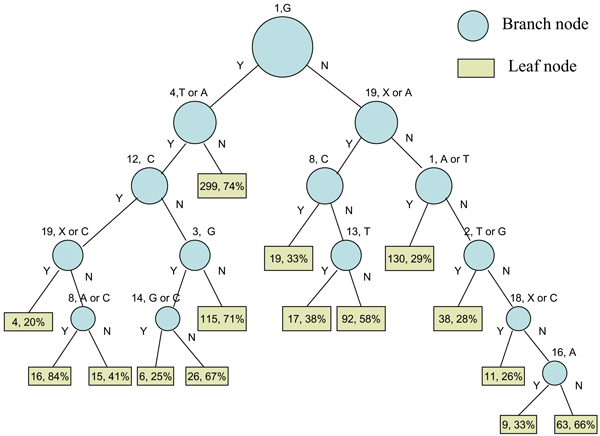
Decision tree diagram for known 860 effective and 860 ineffective siRNA sequences. The top of the branch node indicates the position and nucleotide attribute, e.g., "4, T or A" represents the cDNA position 4 with the nucleotide T or A. "X" indicates an arbitrary nucleotide, i.e., A, G, C or T. The bottom of the branch node shows yes (Y) and no (N). The leaf node indicates the number of effective siRNA sequences and its percentage, e.g., "299, 74%" means that the number of effective siRNA sequences is 299 and its percentage indicates 74% (= 299/404).